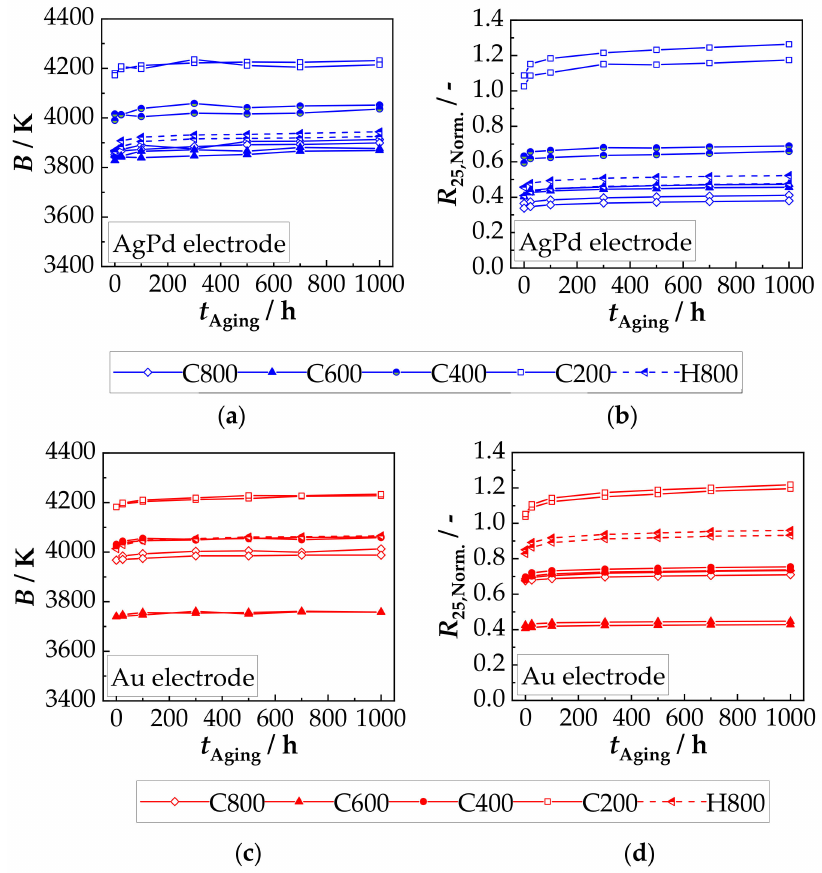
Figure 9. Aging-related change in ( a ) B and ( b ) R 25,Norm. of components with AgPd electrodes and ( c ) B and ( d ) R 25,Norm. of components with Au electrodes during aging at 125 ◦ C in